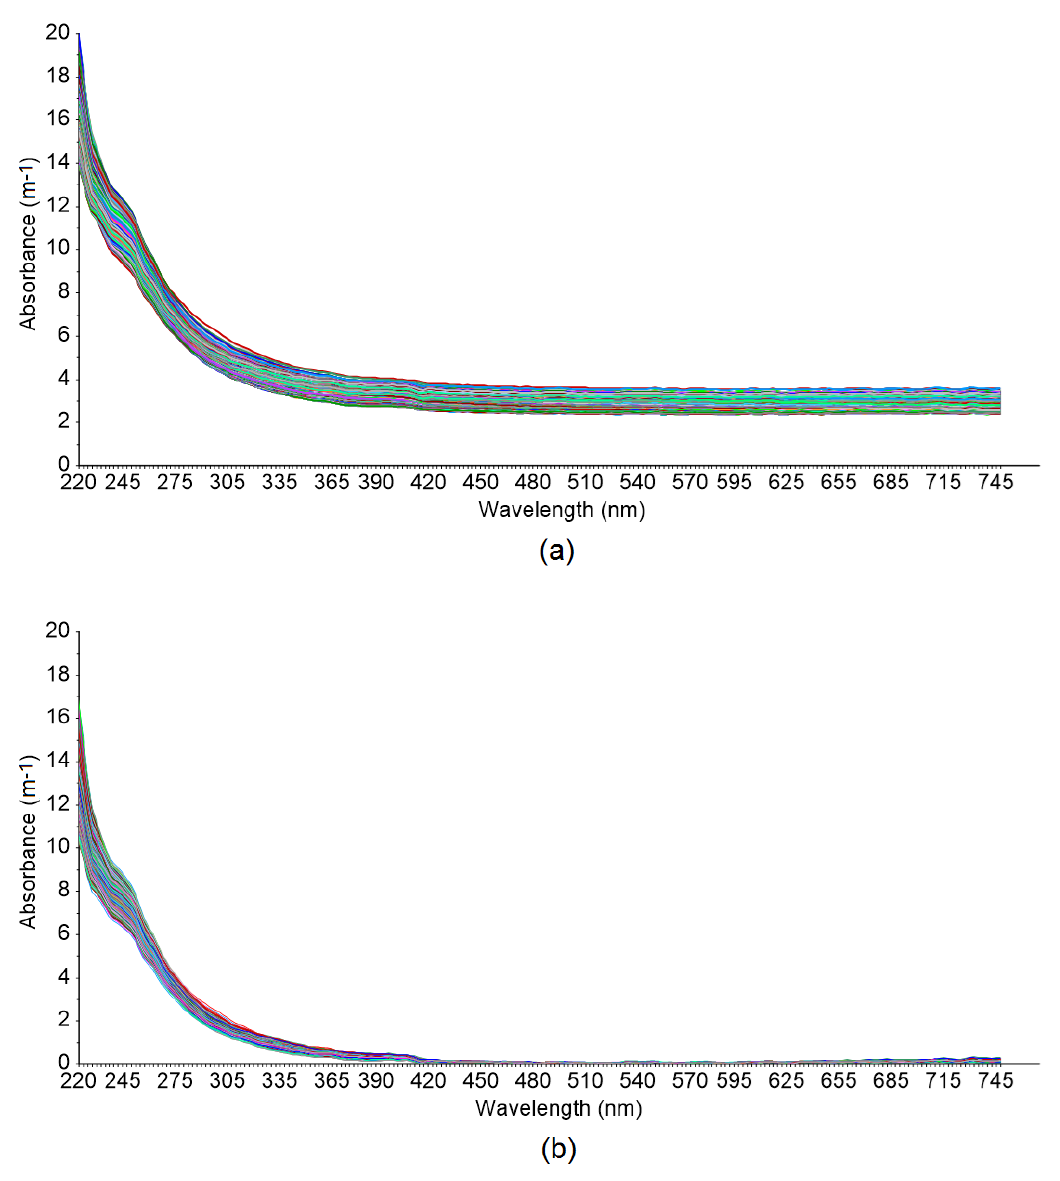
Figure A2. Post chloramination spectra at the WTP: ( a ) Uncompensated spectra and ( b ) particle compensated spectra (absorbance is relatively high in uncompensated spectra due to particle interference and after particle compensation absorbance is significantly reduced).